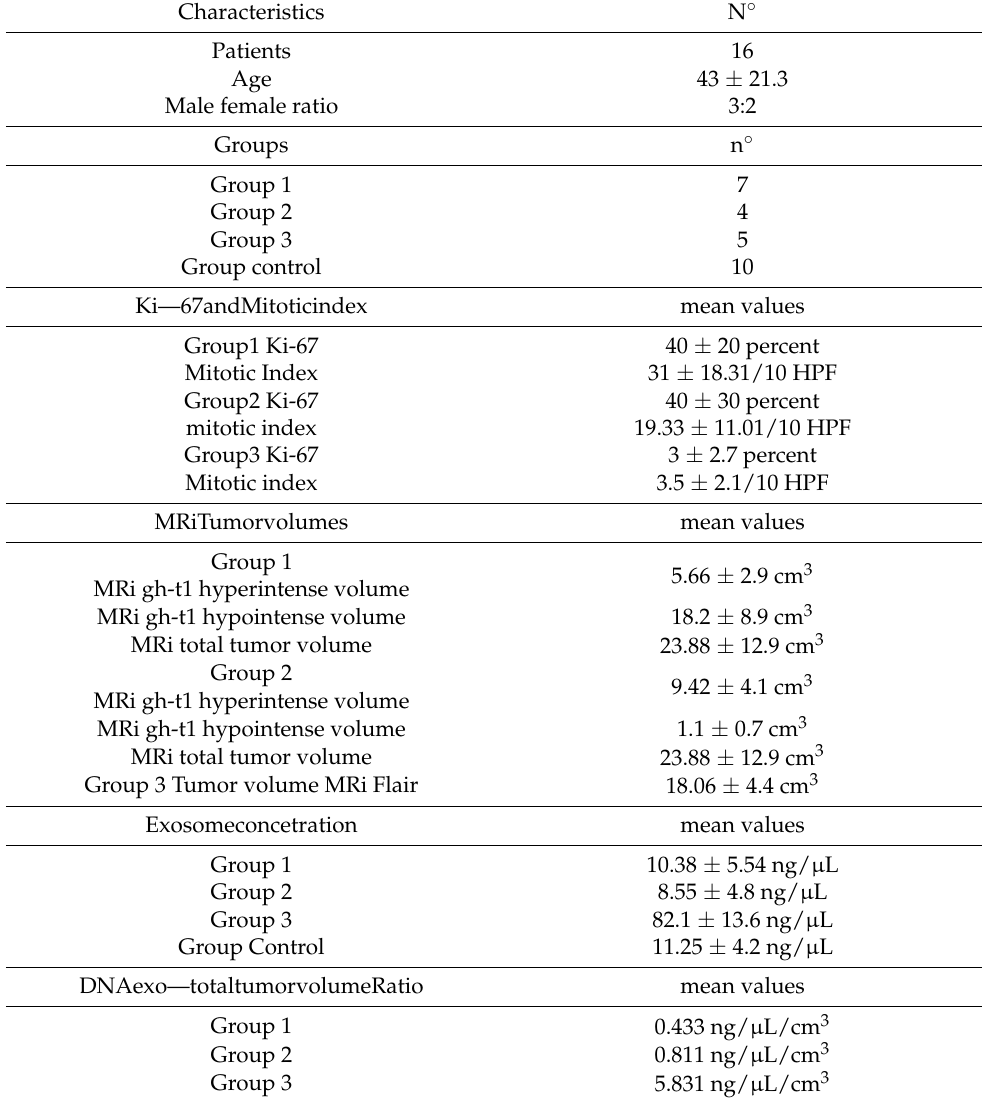
Table 1. Summary of Patients